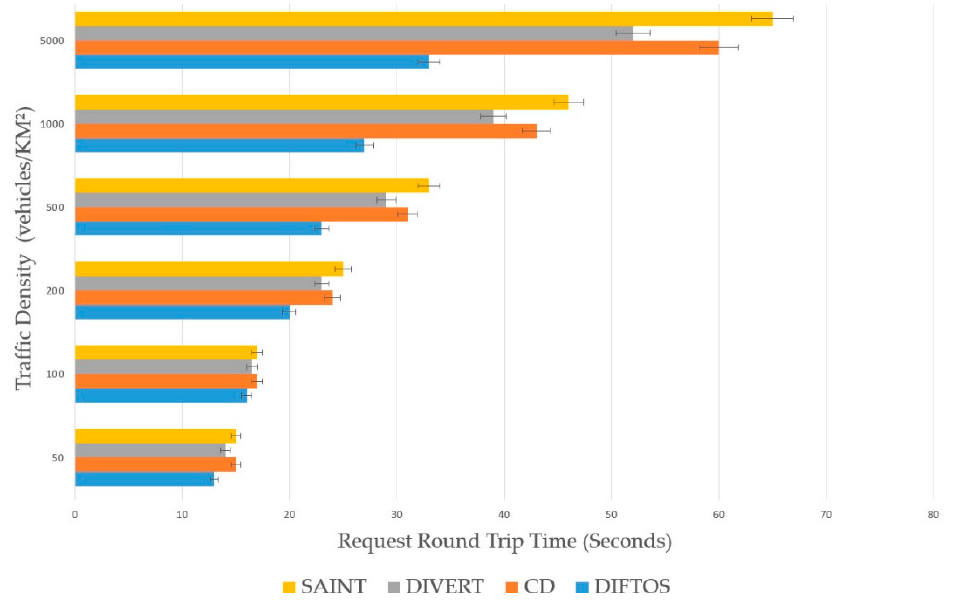
Figure 5. Traffic density vs request round trip time.